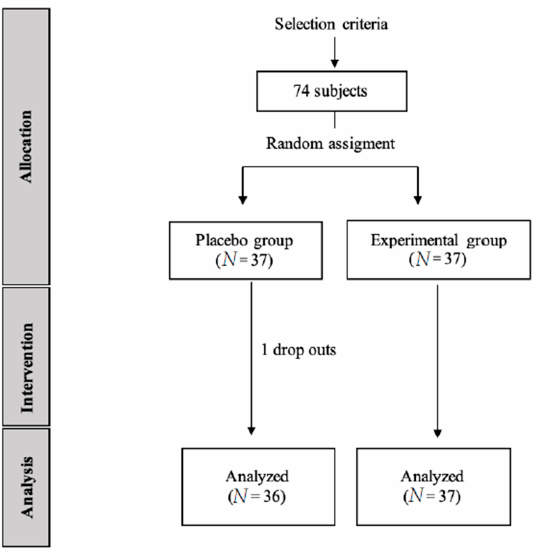
Figure 1. CONSORT flow diagram of subject